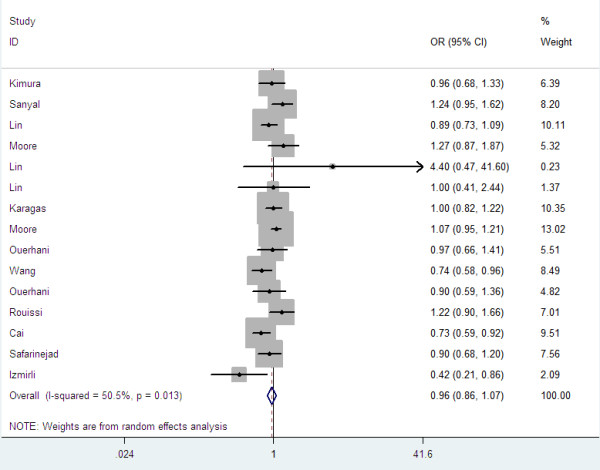
Forest plots for MTHFR Ala222Val polymorphism and risk of bladder cancer in overall populations (Ala allele vs Val allele).